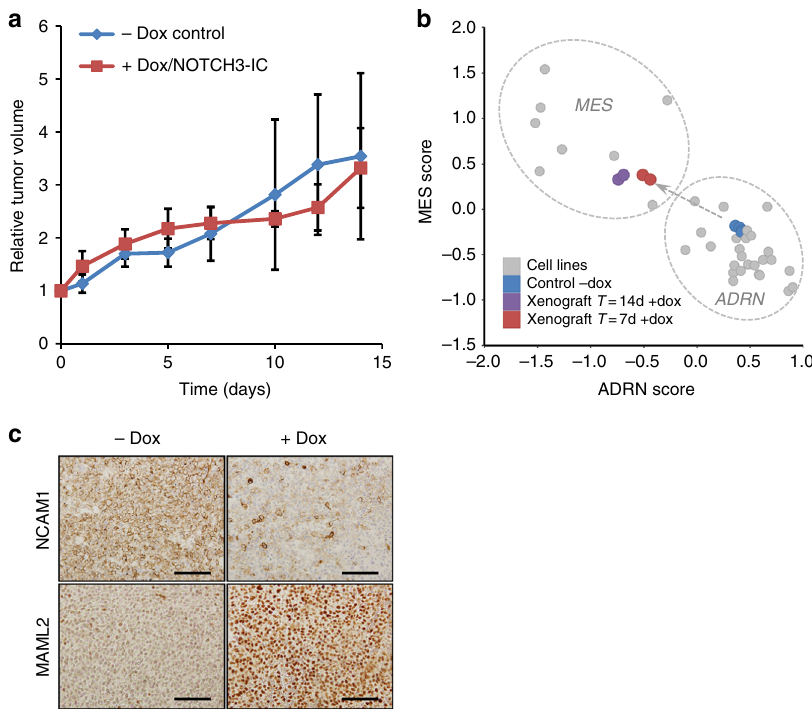
Fig. 7 Induction of ADRN-to-MES reprogramming is tumorigenic in vivo. a Growth of SH-SY5Y-NOTCH3-IC xenograft with ( + dox, red) or without ( − dox, blue) doxycycline in the drinking water. Error bars represent standard deviation. Y -axis shows relative tumor growth; x -axis depicts time in days. Source data are provided as a Source Data fi le. b mRNA analysis of ADRN and MES signature scores of SH-SY5Y-NOTCH3-IC xenograft tumors with induction of NOTCH3-IC. Non-induced control tumors ( n = 4) are depicted in blue, tumors with 7 or 14 days NOTCH3-IC expression ( n = 4) are shown in red and purple, respectively. Dashed lines group various neuroblastoma cell lines (gray dots) according to MES and ADRN phenotypes for reference (see ref. 1 ). c Immunohistochemistry of NCAM1 and MAML2 on tumors with ( + dox) or without ( − dox) 7 days of NOTCH3-IC induction. dox, doxycycline. Scale bar, 100 µ